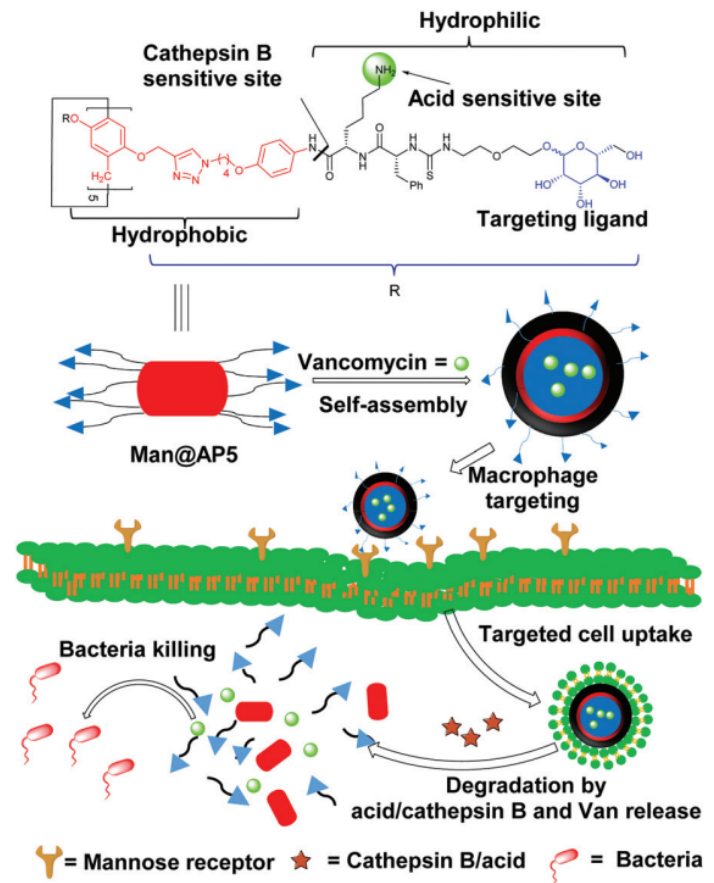
Figure 4. Schematic illustration of a Van-loaded mannosylated vesicle (Man@AP5-Van) and its targeted uptake, transport, degradation, Van release, and bacterial inhibition. Reproduced with the permission of reference [71]. Copyright © Royal Society of Chemistry 2020.